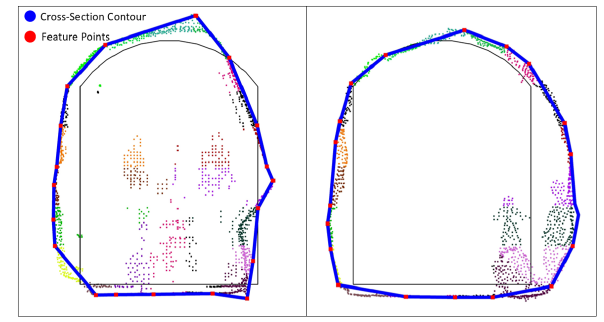
Figure 3. Cross-section point segmentation and the extracted feature points and contours. The point groups G i =1 ··· n in each cross-section is demonstrated in different colors. The red points are the extracted feature points. The blue lines are the contours. The black curve is the profile of the design cross-section S .